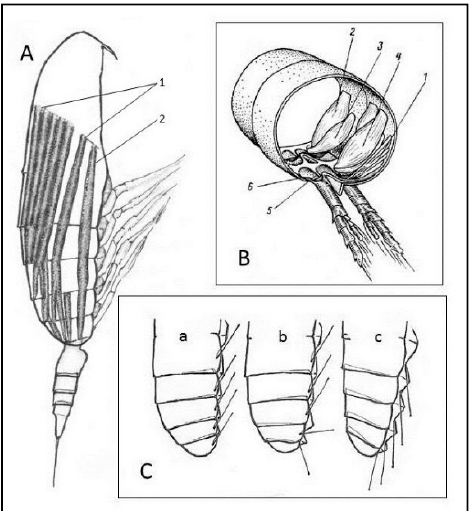
Figure 3. Calanus helgolandicus. ( А ): Longitudinal truncal muscles scheme: 1 ― dorsolateral muscle bundles; 2 ― ventral muscle bundles. ( B ): Indirect dorsoventral muscles of the third and